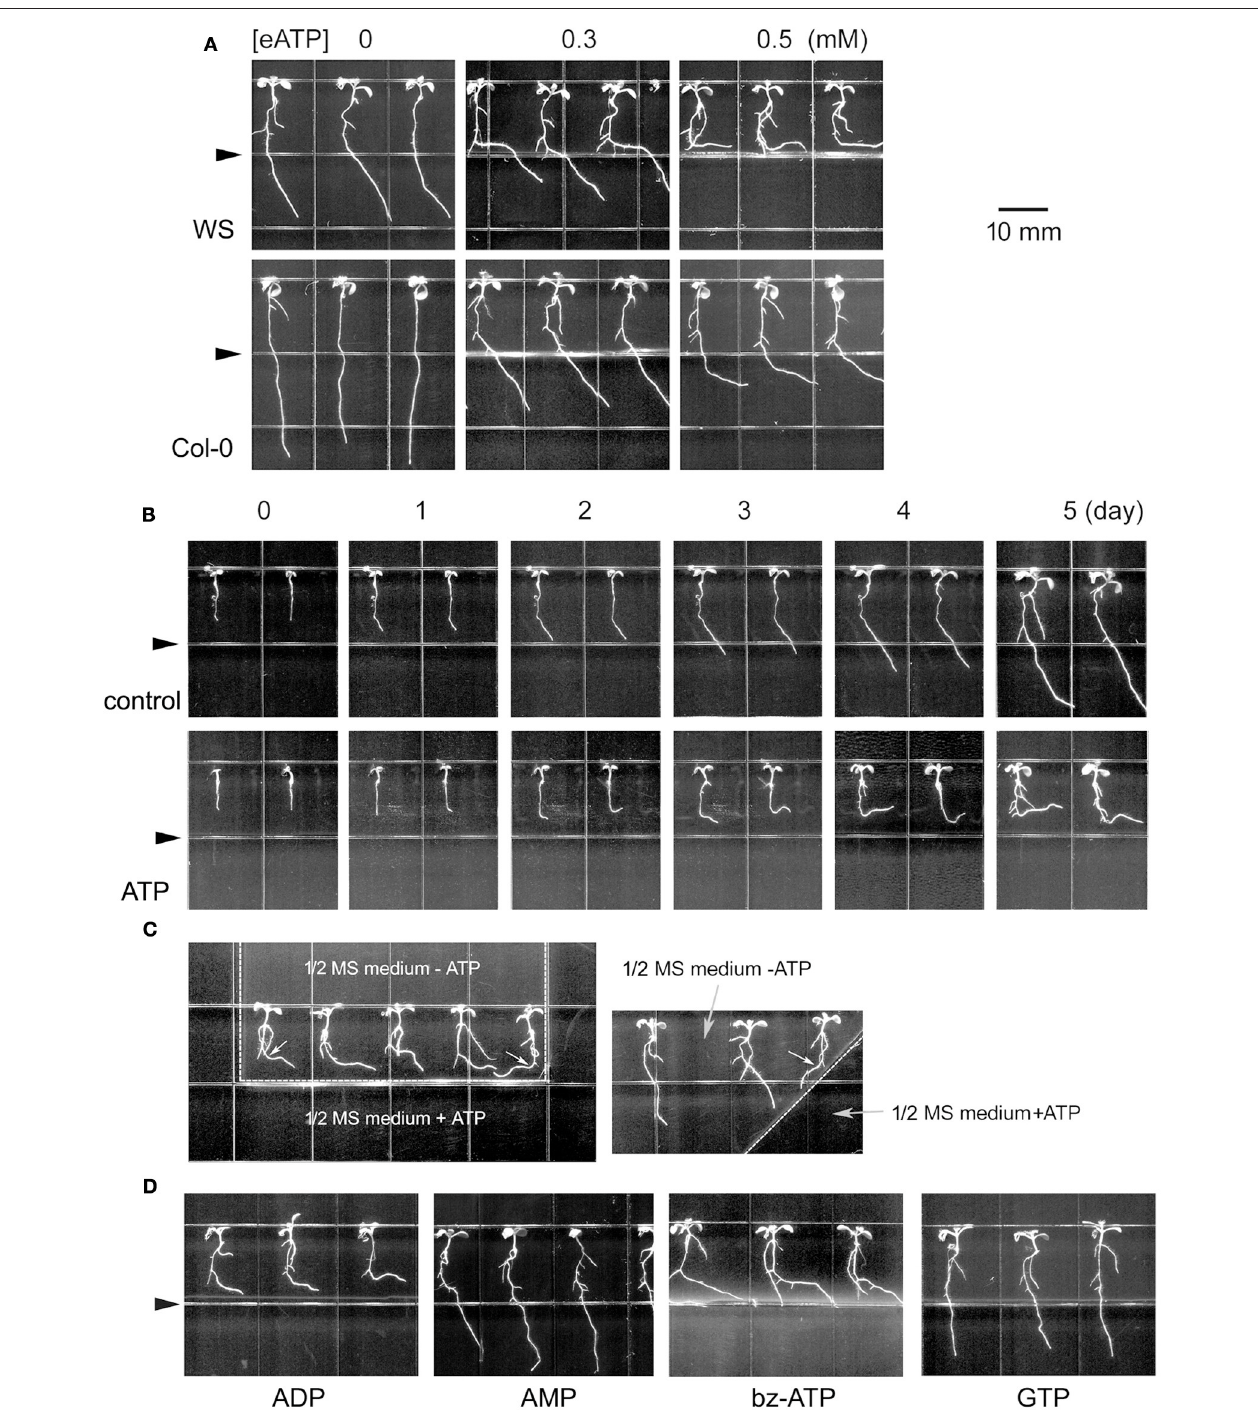
FIGURE 1 | Extracellular ATP avoidance response of Arabidopsis roots. (A) Seedlings of Arabidopsis thaliana (WS and Col-0 ecotype) grown in jointed medium. Note the bending roots. The concentration of ATP in the lower part is marked on top of the photos. (B) Time-lapse images of seedlings grown in jointed medium without (control) or with 0.5 mM ATP (ATP) in the lower part. The photograph time is marked on top of the photos. (C) Seedlings grown in U-shaped (left) or diagonal (right) jointed medium containing 0.5 mM ATP. Note the ATP avoidance response of roots. The small white arrows in the figure mark the different bending styles (bent to left or right) of seedlings at different position. (D) Seedlings grown in jointed medium containing 0.5 mM of a non-hydrolyzable ATP analog (bz-ATP) or some nucleotide phosphates (ADP, AMP or GTP). In (B–D) WS was used as material. Seedlings in (A,C,D) were photographed 5 days after transplantation. Triangles in (A,B,D) mark the joint line of the two media. In (C) the joint line of the two media is marked with a dotted line. The scale bar is showed on right side of (A) .